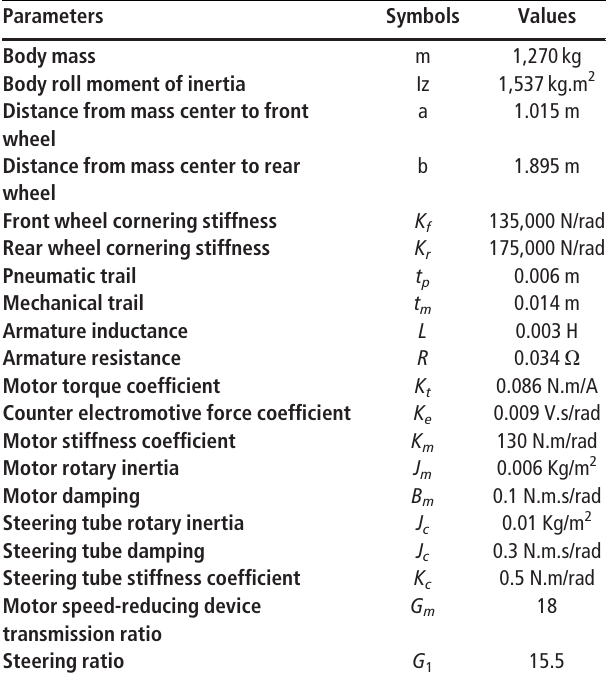
Table 2 Parameters of SBW